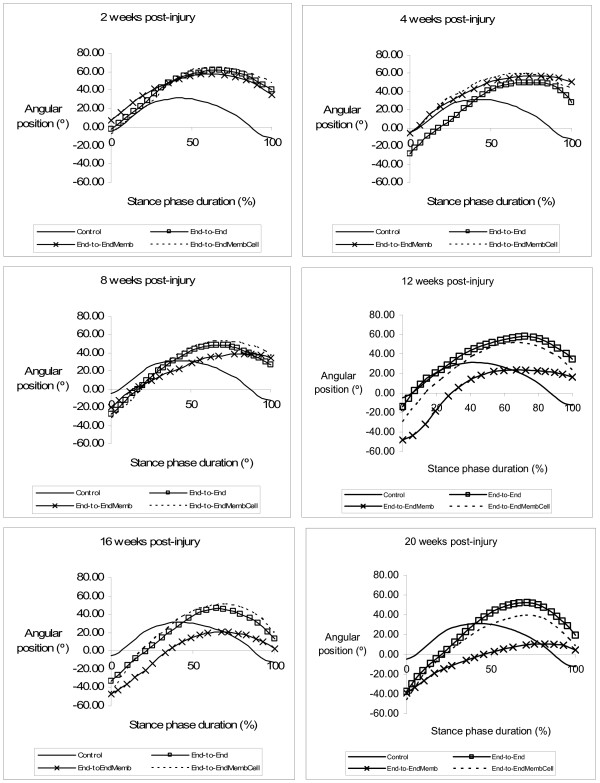
Kinematics plots in the sagittal plane for the angular position (°) of the ankle as it moves through the stance phase, during the healing period of 20 weeks. The mean of each group is plotted.